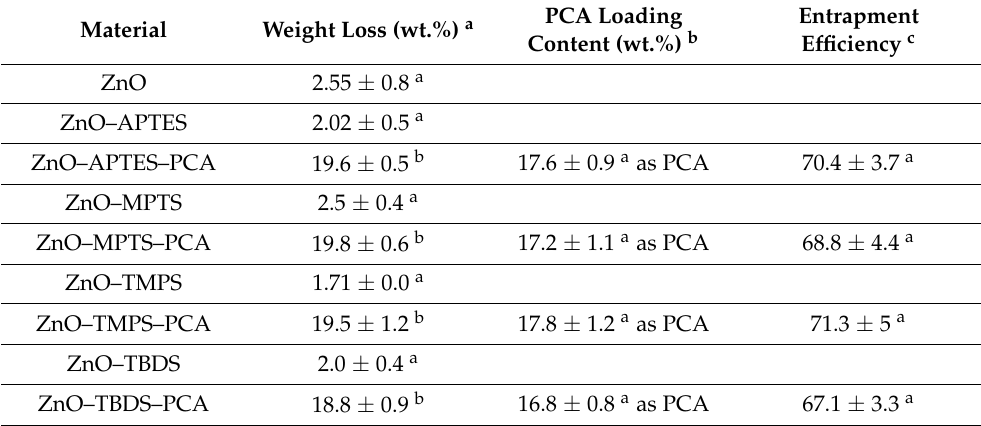
Table 1. Thermogravimetric analysis and PCA loading properties for surface-modified ZnO nanoparticles.